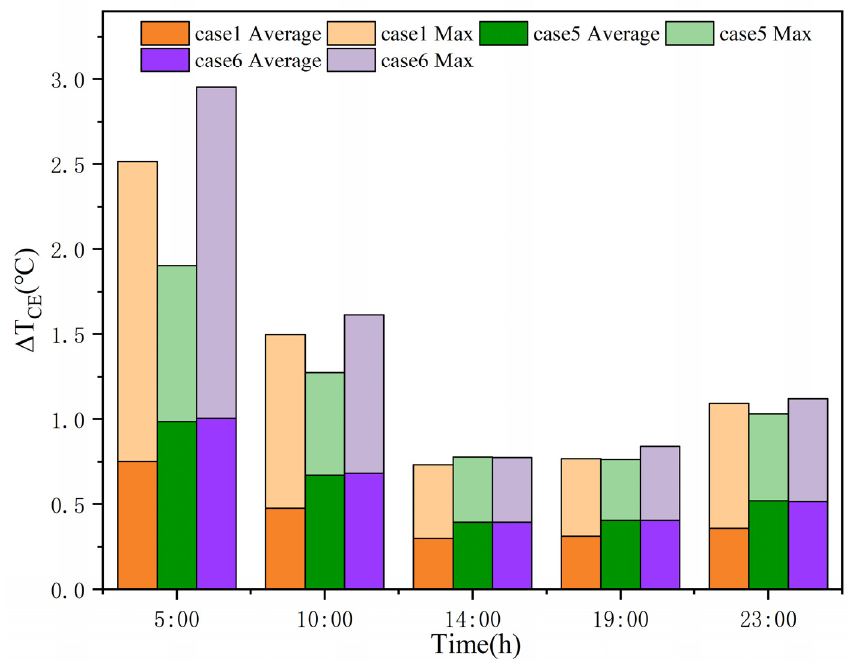
Figure 10. Average cooling effect and maximum cooling effect in cases 1, 5 and 6.